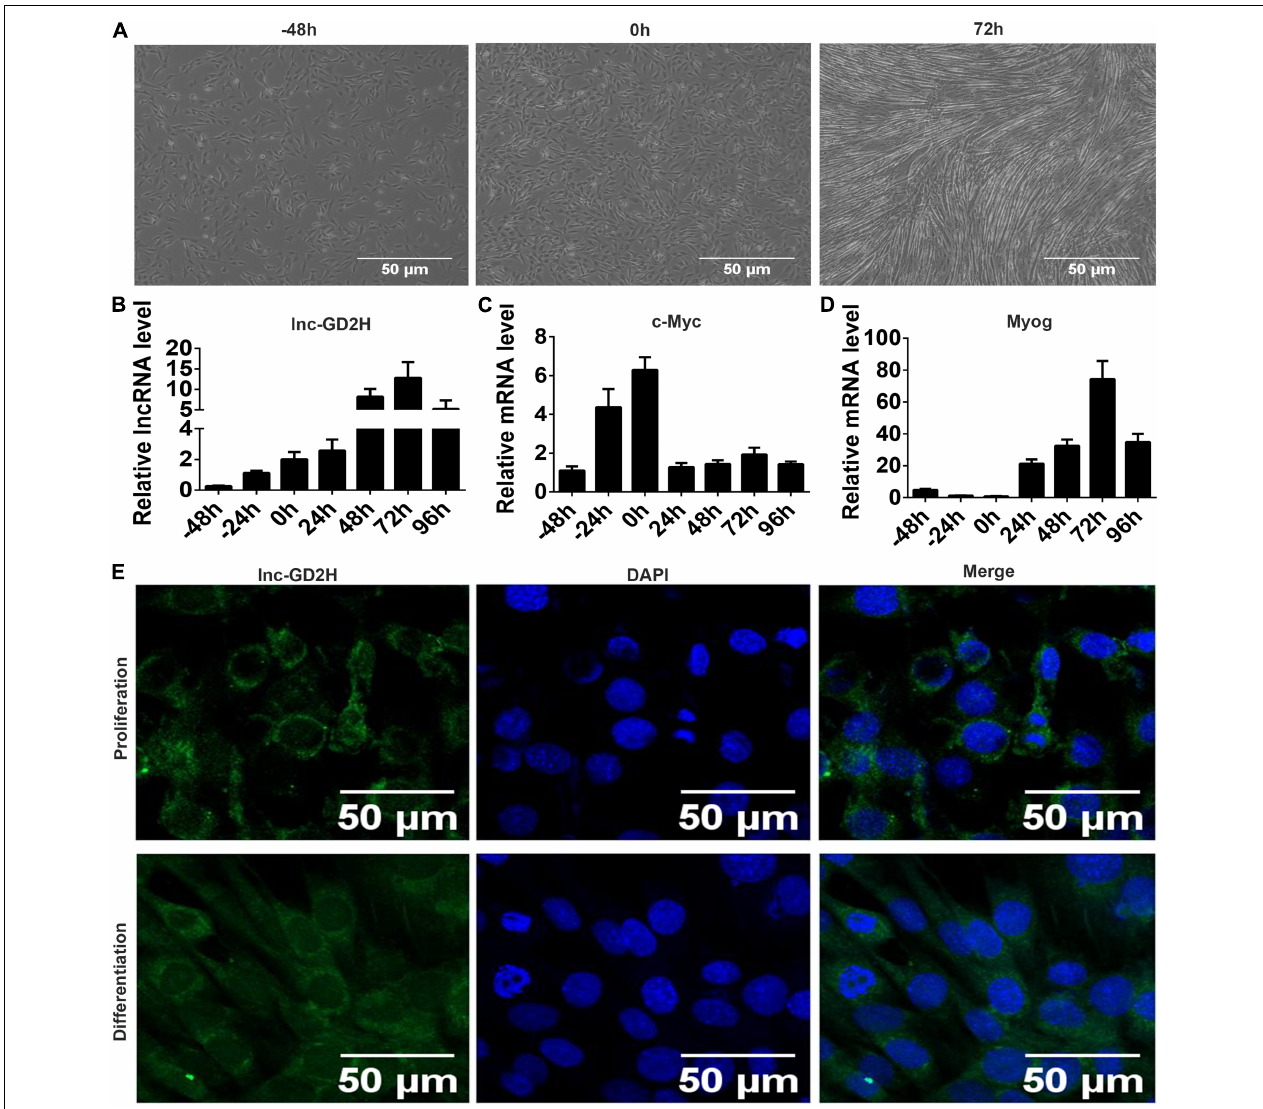
FIGURE 1 | Expression patterns and FISH localization of lnc-GD2H during myoblast proliferation and differentiation. (A) Representative photos of C2C12 cells at –48, 0, and 72 h during proliferation and differentiation. (B) lnc-GD2H expression level during myoblast proliferation and differentiation. (C) c-Myc expression level during myoblast proliferation and differentiation. (D) Myog expression level during myoblast proliferation and differentiation. (E) RNA FISH for detecting lnc-GD2H in C2C12 cells. Green: lnc-GD2H, blue: DAPI staining, n =